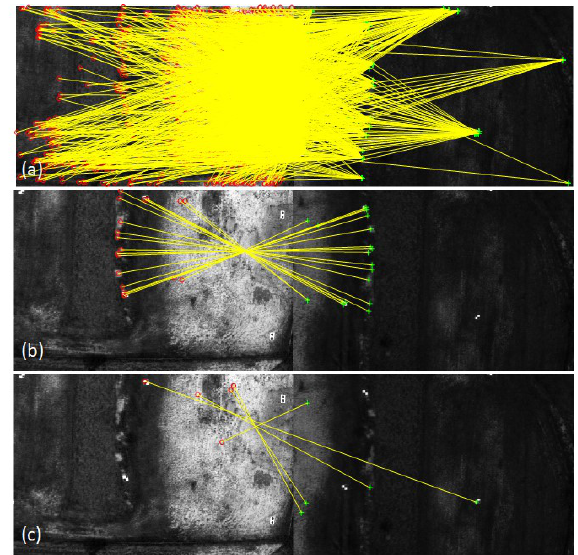
Figure 6. Match pairs between same bands of hypercubes in side strip (180º rotation can be noticed). (a) Image matching with unfiltered matches. (b) Filtering by Helmert transformation combined with majority voting. (c) Filtering by MSAC.